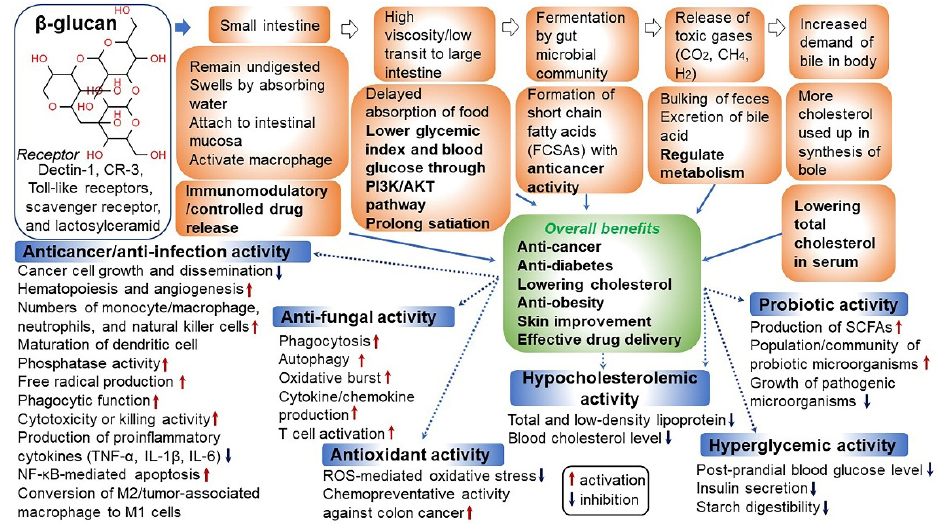
Figure 3. Human health benefits of β -glucan associated with anti-cancer/anti-infection, anti-fungal, antioxidant, hypocholesterolemic, hyperglycemic, and probiotic activity. Binding receptors for β -glucan have been known to be dectin-1, complement receptor 3 (CR3), scavenger receptor, and lac- tosylceramid. Of these, dectin-1 is a major receptor [18,52–55].